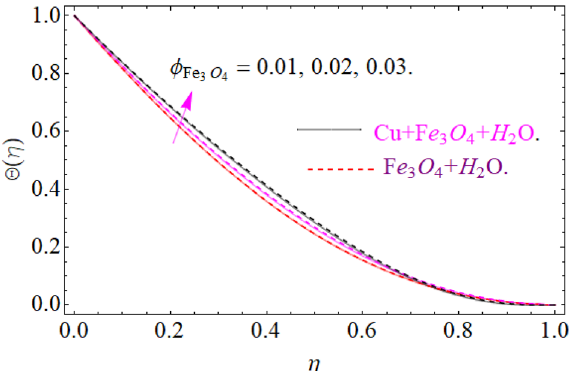
Figure 13. Impression of φ Fe 3 O 4 on Θ( η ), When M = 0.2, φ Cu = 0.02, Pr = 6.2, Re ω = 0.3, Re � = 0.13 .